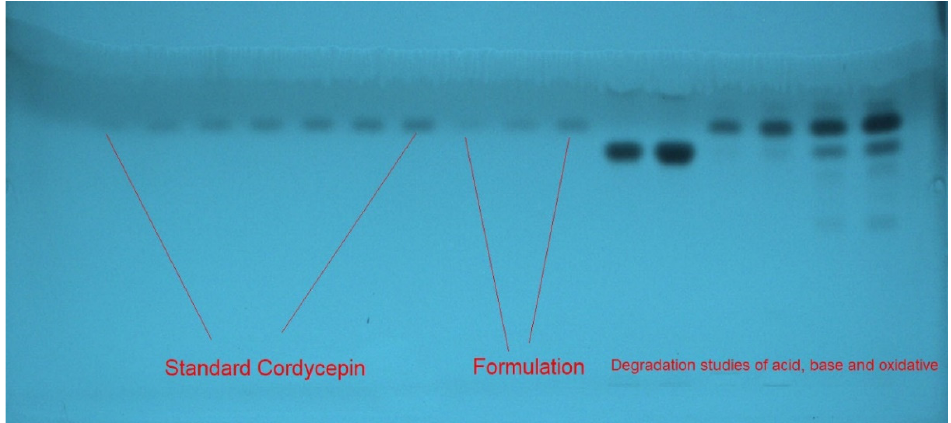
Figure 2. A representative thin-layer chromatographic (TLC) chromo-plate of standard CDN, for- mulation, and forced degradation study samples recorded using greener ethanol–water (75:25 v / v ) eluent system for current protocol.